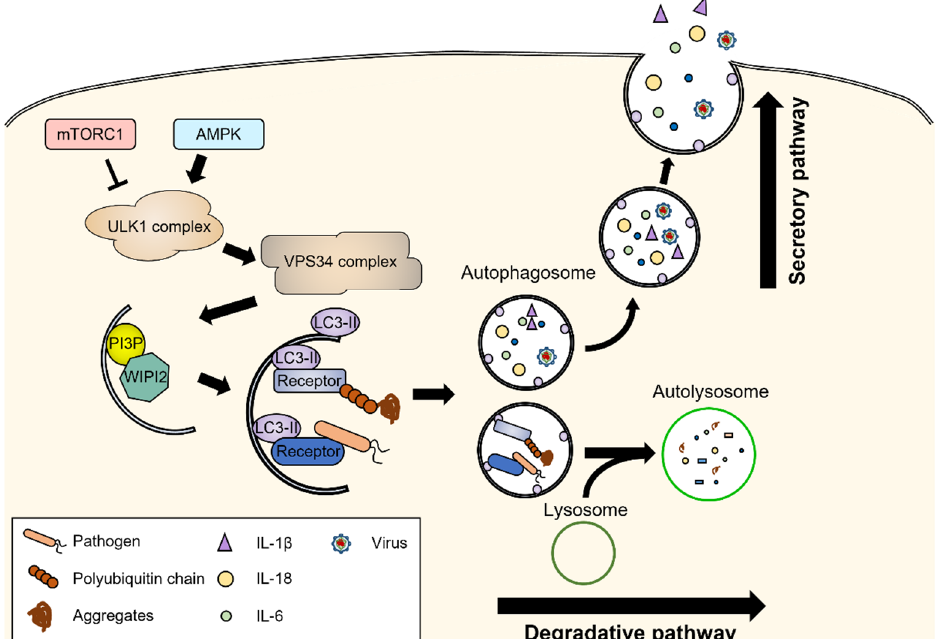
Figure 1. Outline of degradative and secretory autophagy pathways. Various stressors stimulate mTORC1 and AMPK, upstream signaling molecules of autophagy, which phosphorylate the ULK1 complex. The ULK1 complex sequentially activates the VPS34 complex, which generates PI3P at membrane sources and initiates autophagosome formation. With the aid of autophagic receptors, cargos are recruited to the autophagosomes. In the degradative autophagy pathway, the autophagosomes are fused with lysosomes, and their cargos are degraded by lysosomal enzymes. In the secretory autophagy pathway, autophagosomes escape the lysosomal degradation pathway and move to the cell periphery and fuse with the plasma membrane. The key inflammatory signaling molecules, such as interleukins, are released into the extracellular environment. Detailed mecha- nisms are described in the text.